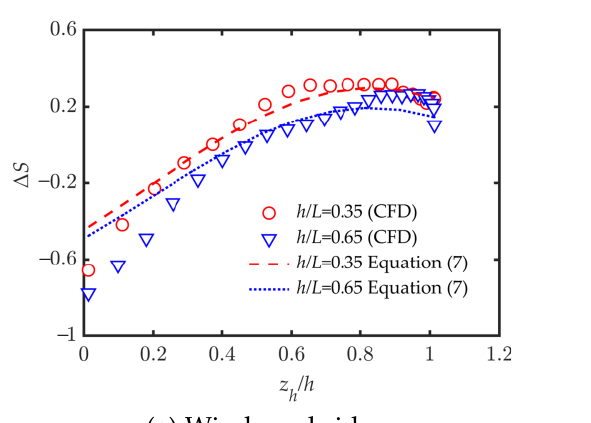
Figure 18. Validation of hill speedup ratio model for different slopes.